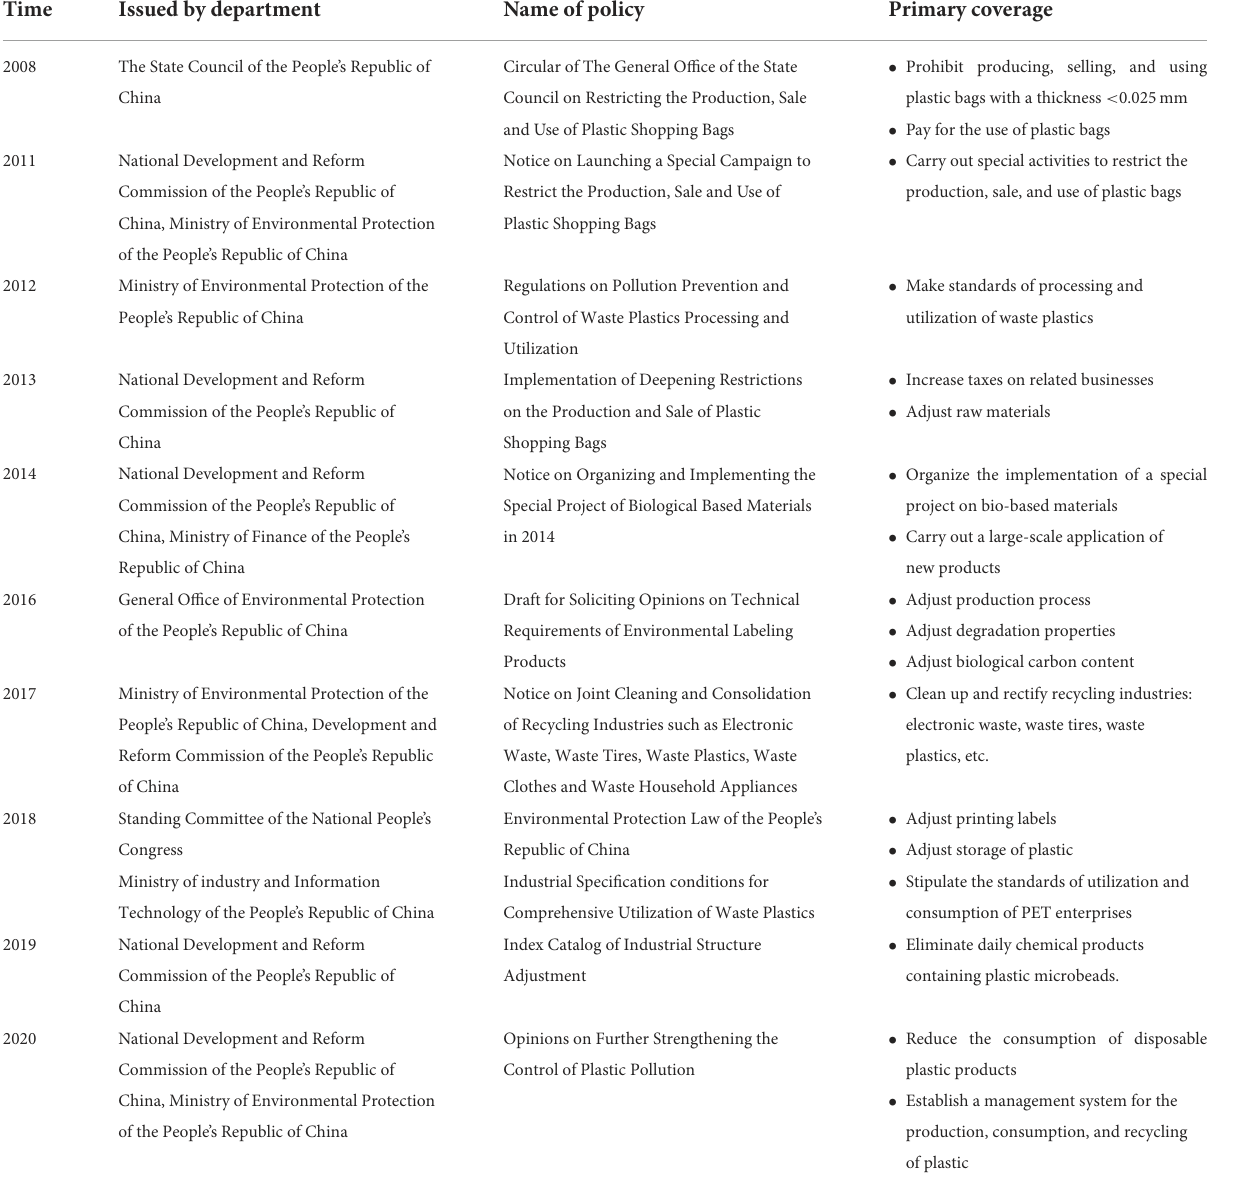
TABLE 1 2008–2020 plastic restriction of China related to supporting policy